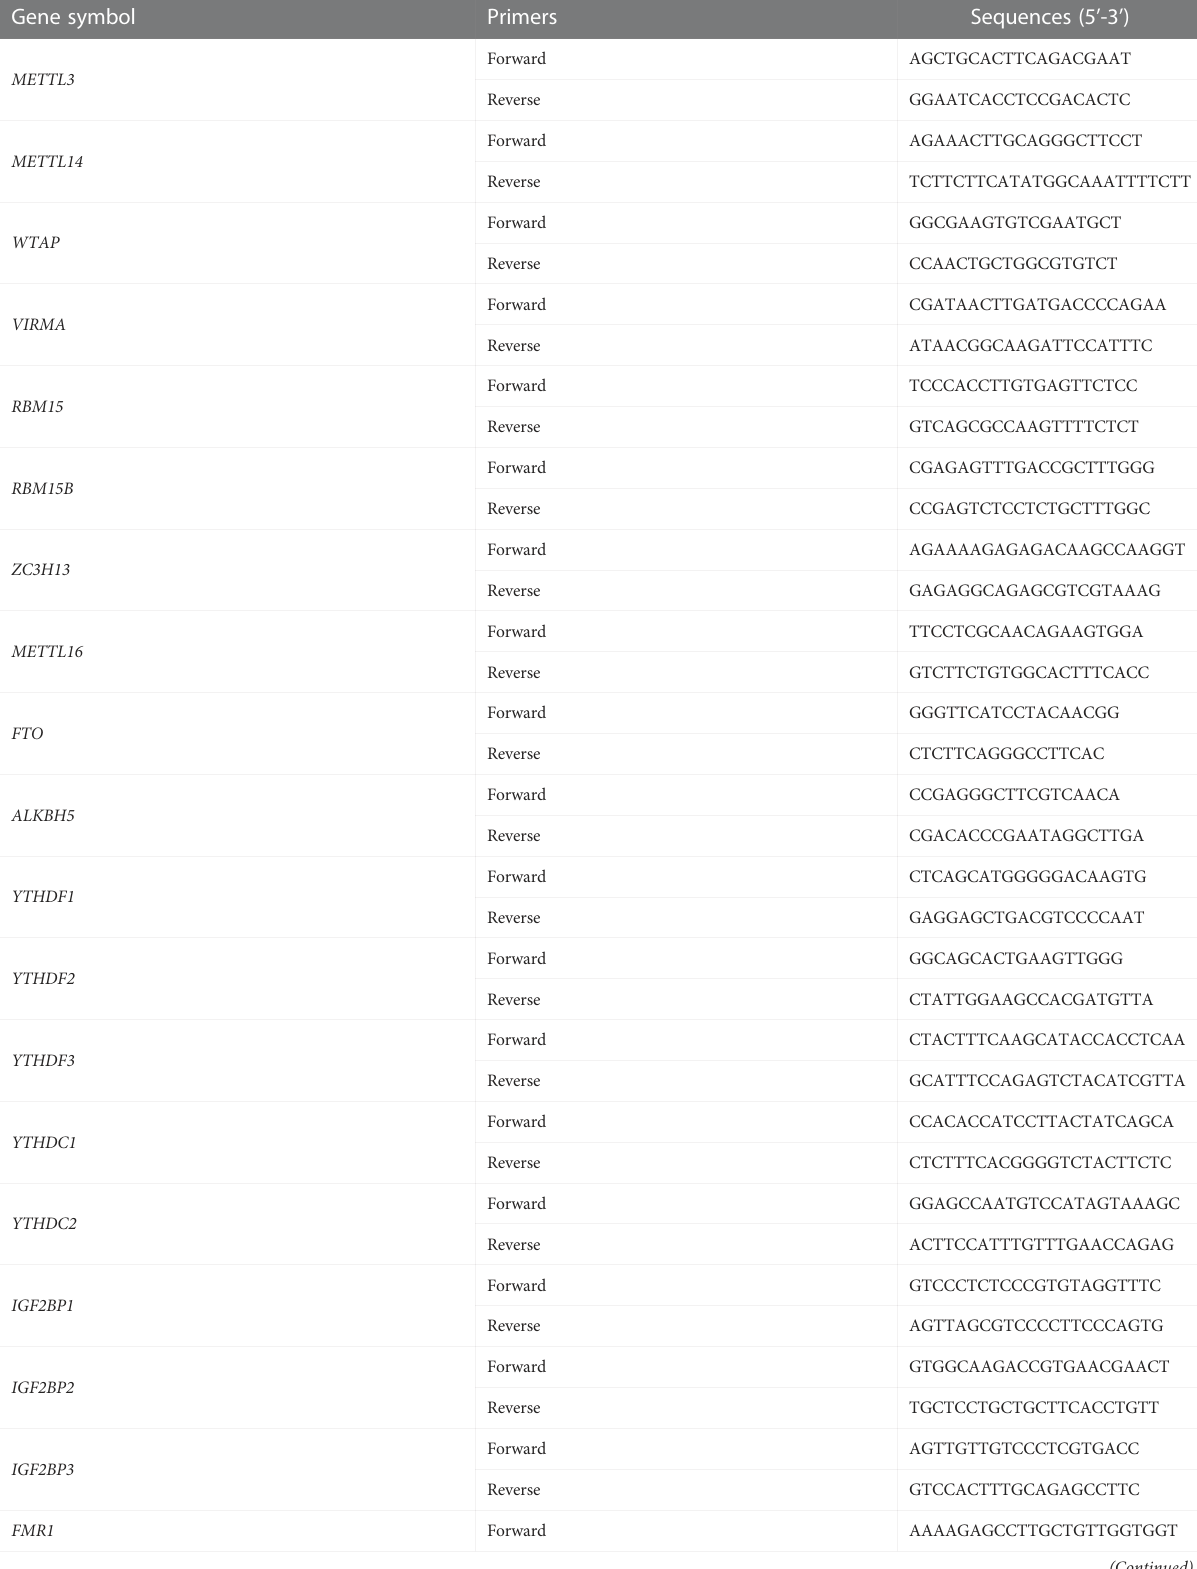
TABLE 1 Sequences of primers for mRNAs qRT-PCR